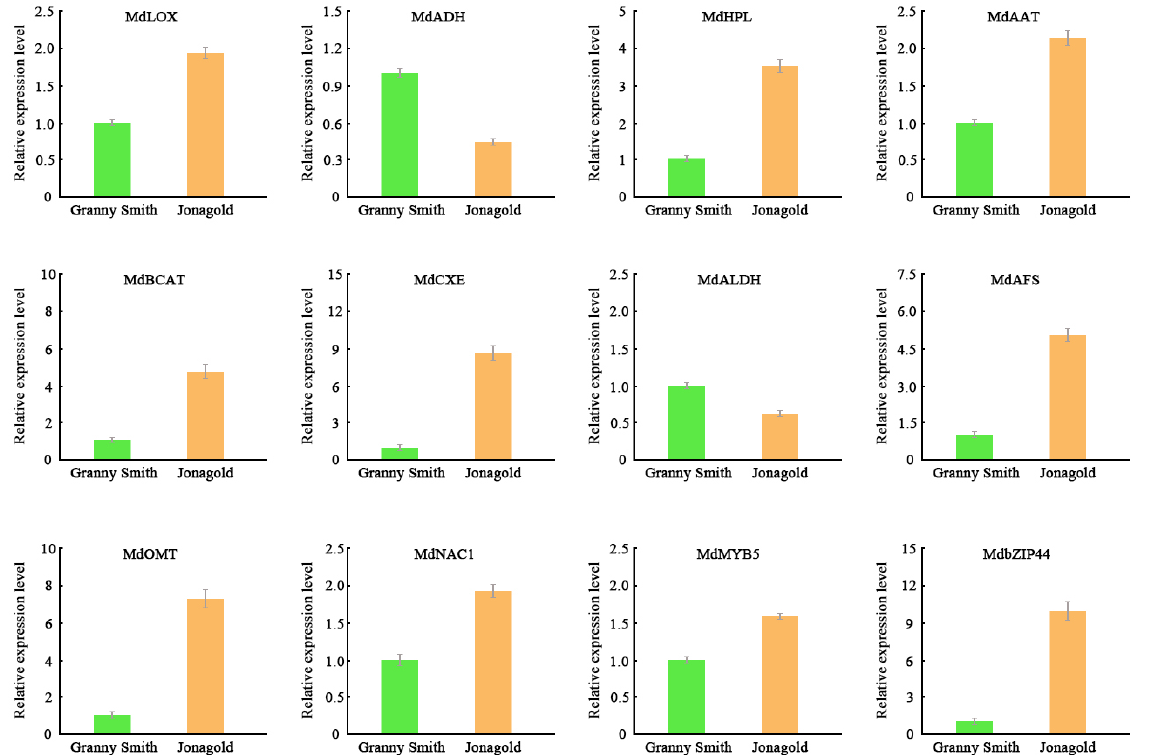
Figure 6. Expression profiles of selected 12 DEGs determined by qRT-PCR.